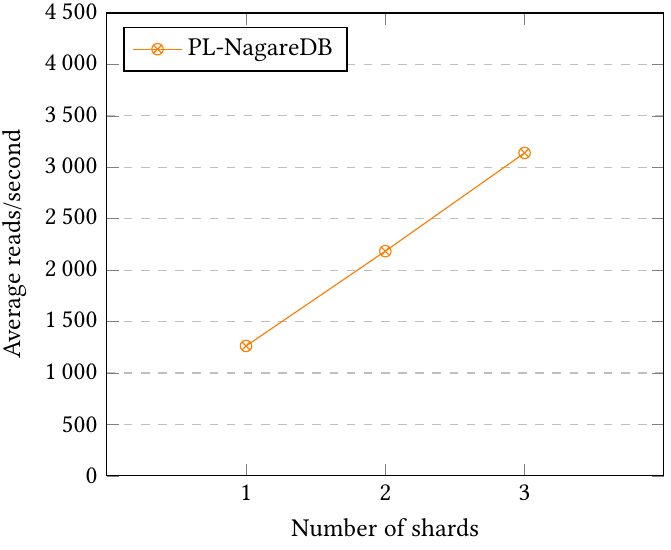
Figure 19. Execution time of a time stamped query, in setups from one to three Figure 2: Sensor reads per second retrieved in a timestamped query, in three different set-ups involving one, two, or three nodes. Single running job.